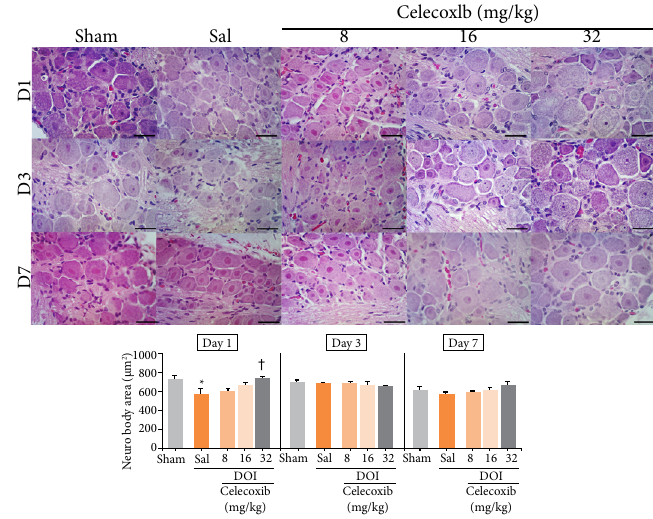
Figure 1 - Histomorphometric analysis of ipsilateral cell body area of trigeminal neurons in rats treated with different doses of a selective cyclooxygenase 2 inhibitor (celecoxib, Eurofarma ® ) and exposed to an experimental model of dental occlusal interference. Two-way analysis of variance (ANOVA)/Bonferroni (mean ± standard error); hematoxylin and eosin, 400×, horizontal line = 50 μ m.